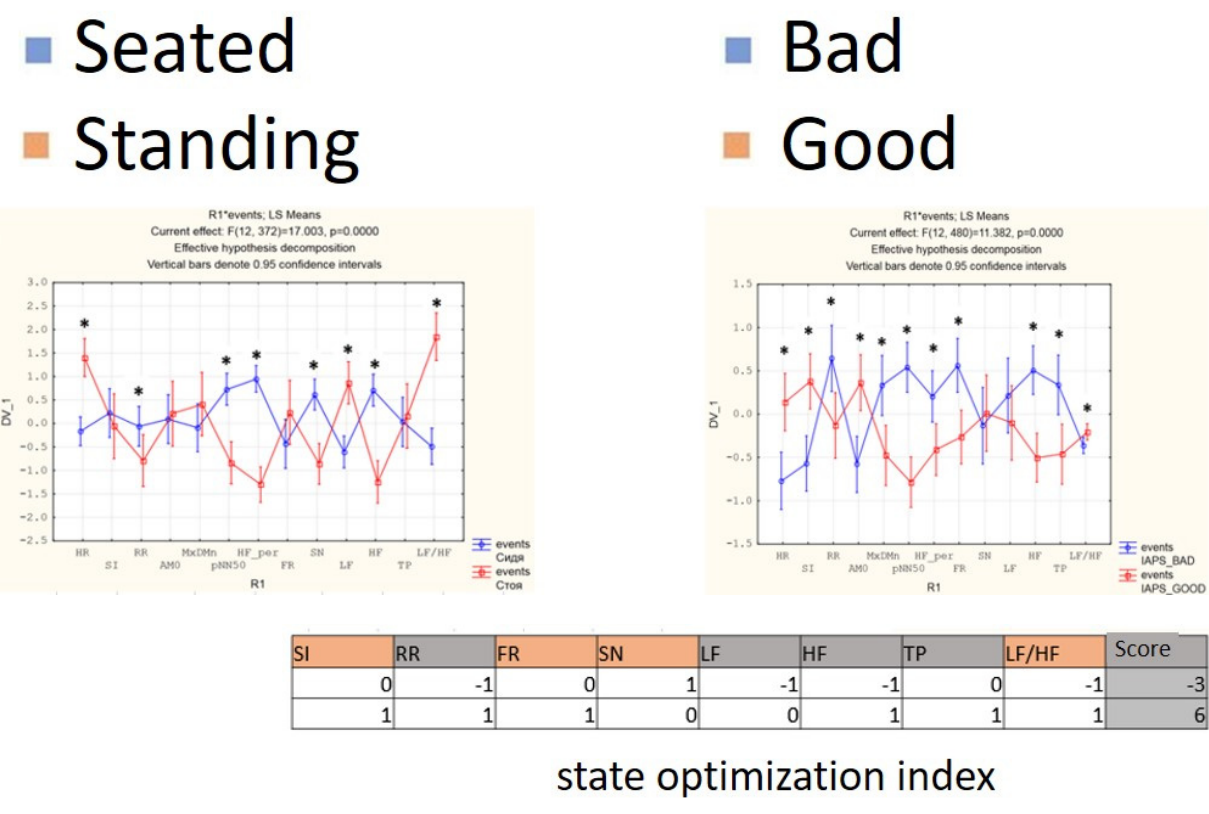
Figure 21. An example of inverse reaction of a test subject, the Basic complex.